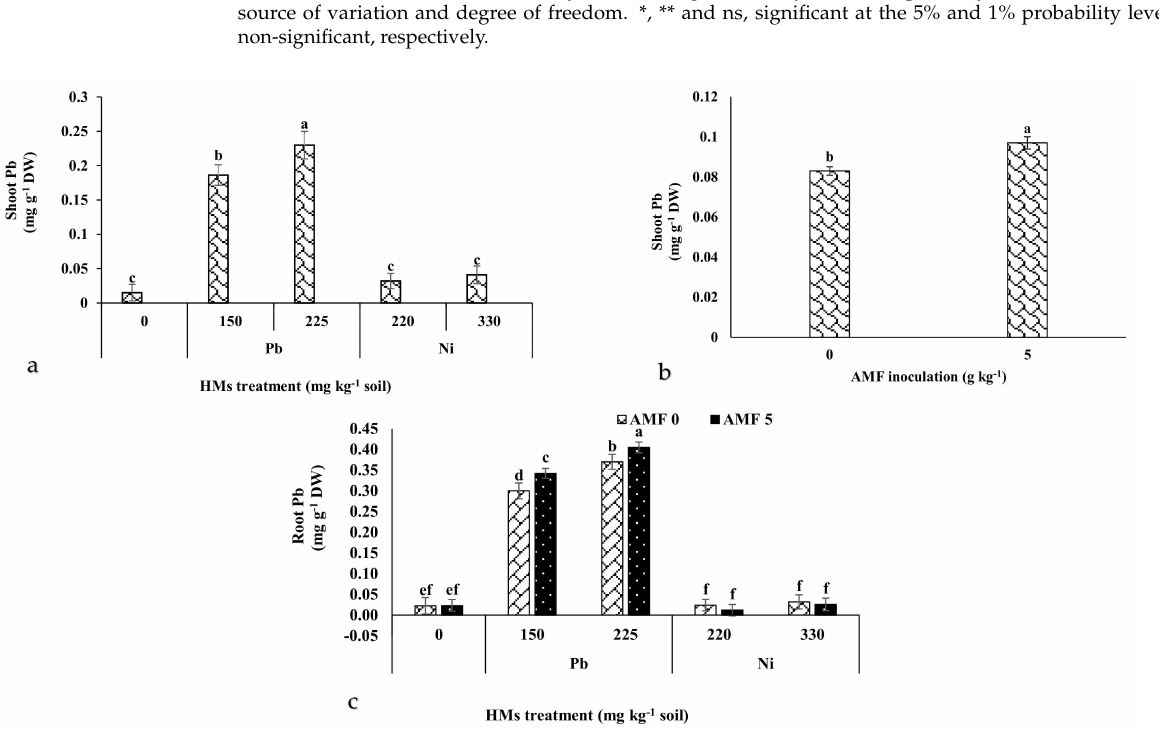
Figure 2. The effect of Pb and Ni (mg kg − 1 soil) heavy metal (HM) stress on shoot Pb content in lavender plants ( a ) inoculated with arbuscular mycorrhizal fungi (AMF) ( b ) and root Pb content under HM stress and AMF inoculation ( c ). Different letters indicate significant differences according to the LSD test at p <